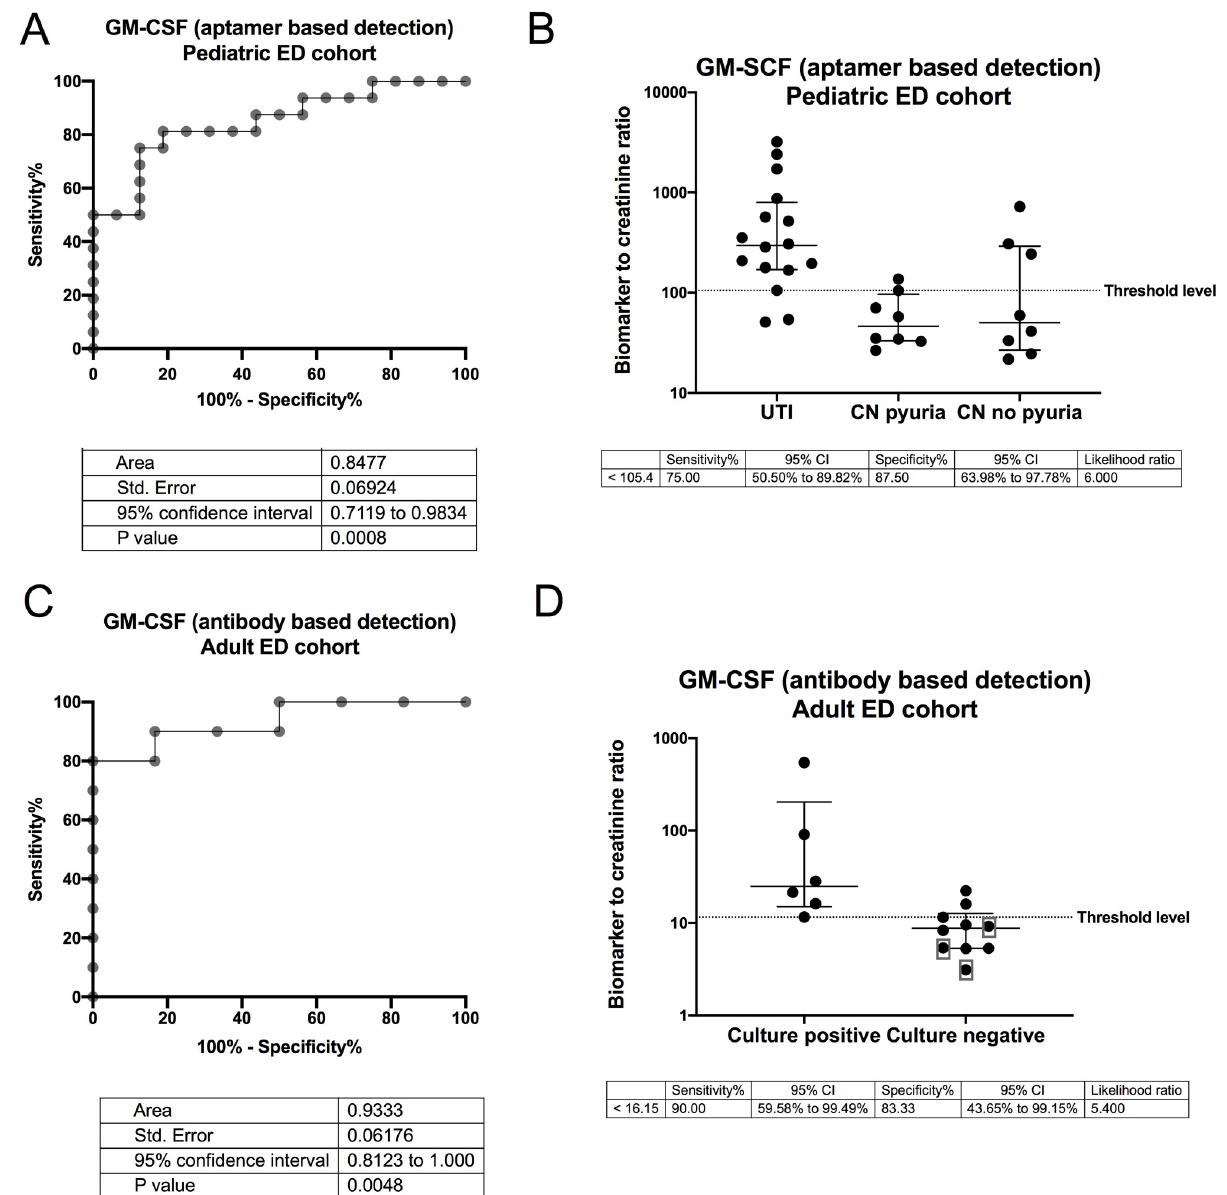
Fig 3. Scatter plots for GM-CSF measured adult ED urine samples using an antibody based Mesoscale platform (A) and measured in pediatric ED urine samples using an aptamer based Somalogic platform (B) are presented. AUCs for the antibody based (C) and the aptamer-based platforms were similar. Units for aptamer-based detection are RFU of urine GM-CSF per mg of urine creatinine and units for antibody based detection are pg of urine GM-CSF per mg of urine creatinine. The patients were selected from an adult population from the Ohio State University Wexner Medical Center Emergency Department and included 6 culture positive and 10 culture negative samples. The mean (range) ages in years were 74 (65–89) for the culture positive and 62 (47–74) for the culture negative group. The majority, 4/6 (67%) in the culture positive and 8/10 (80%) in the culture negative group were female. Urine cultures grew E. coli in four patients, E. Faecalis in one patient and both E. coli and E. Faecalis in one patient. Seven of the culture negative group had no growth and three represented by gray boxes grew mixed flora. Of note these results may not differentiate UTI from asymptomatic bacteriuria which will need investigated in future